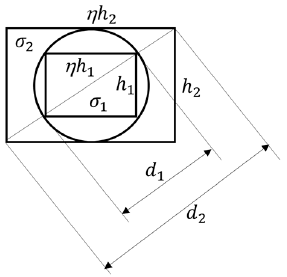
Figure 5. Geometric relationships in the rematch method.